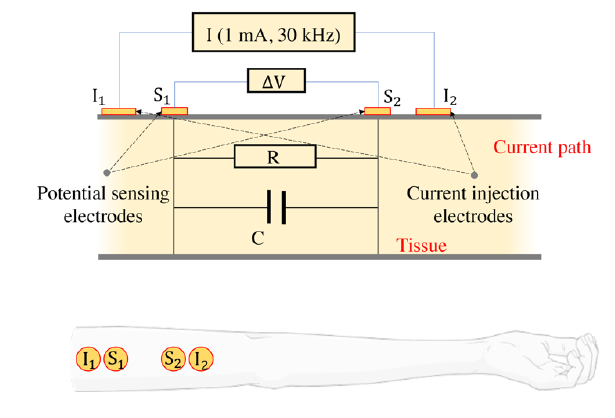
Fig. 1. Electrical bioimpedance electrodes configuration.